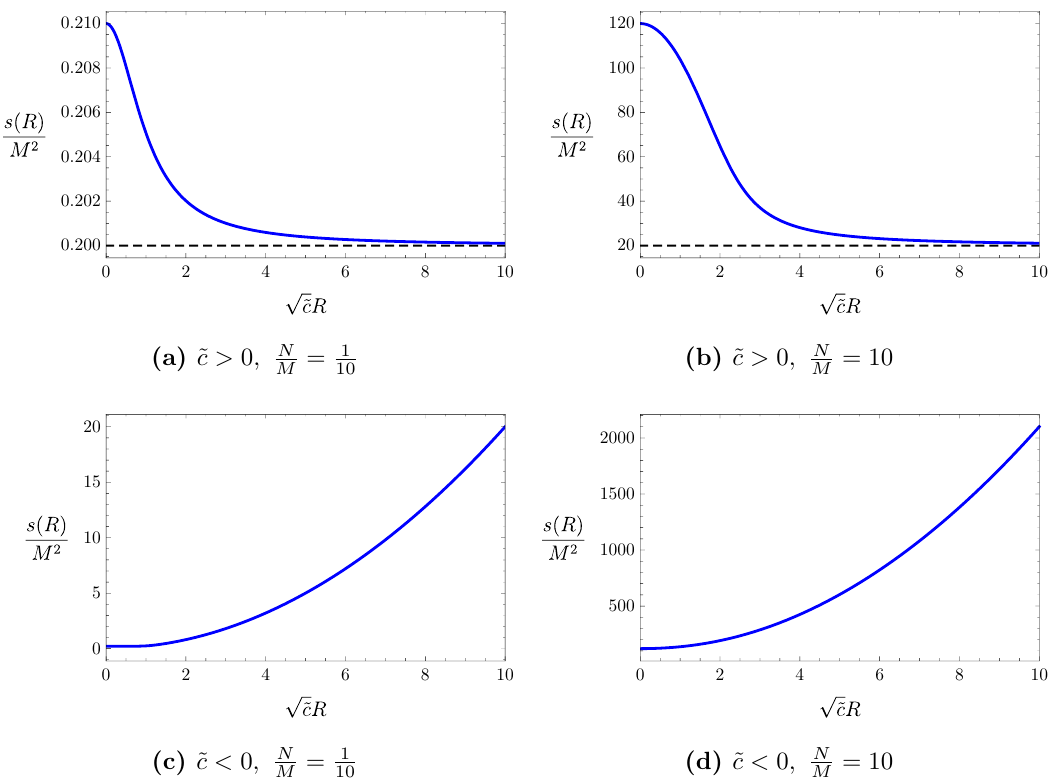
Figure 8. The derivative with repsect to log R of the contribution to the entanglement wedge on- shell action of the symmetric (cid:13)ow (top row) and funnel (bottom row) solutions, for sample values of N=M . For ~ c < 0, corresponding to a (cid:13)ow from a symmetric representation Wilson surface in the UV to a bundle of M2-branes in the IR, the derivative interpolates monotonically between the values at the (cid:12)xed points, given in (5.30). The horizontal dashed line shows the value at the IR (cid:12)xed point. For ~ c > 0, corresponding to a funnel solution, the coe(cid:14)cient of the logarithm in the on-shell action increases monotonically without